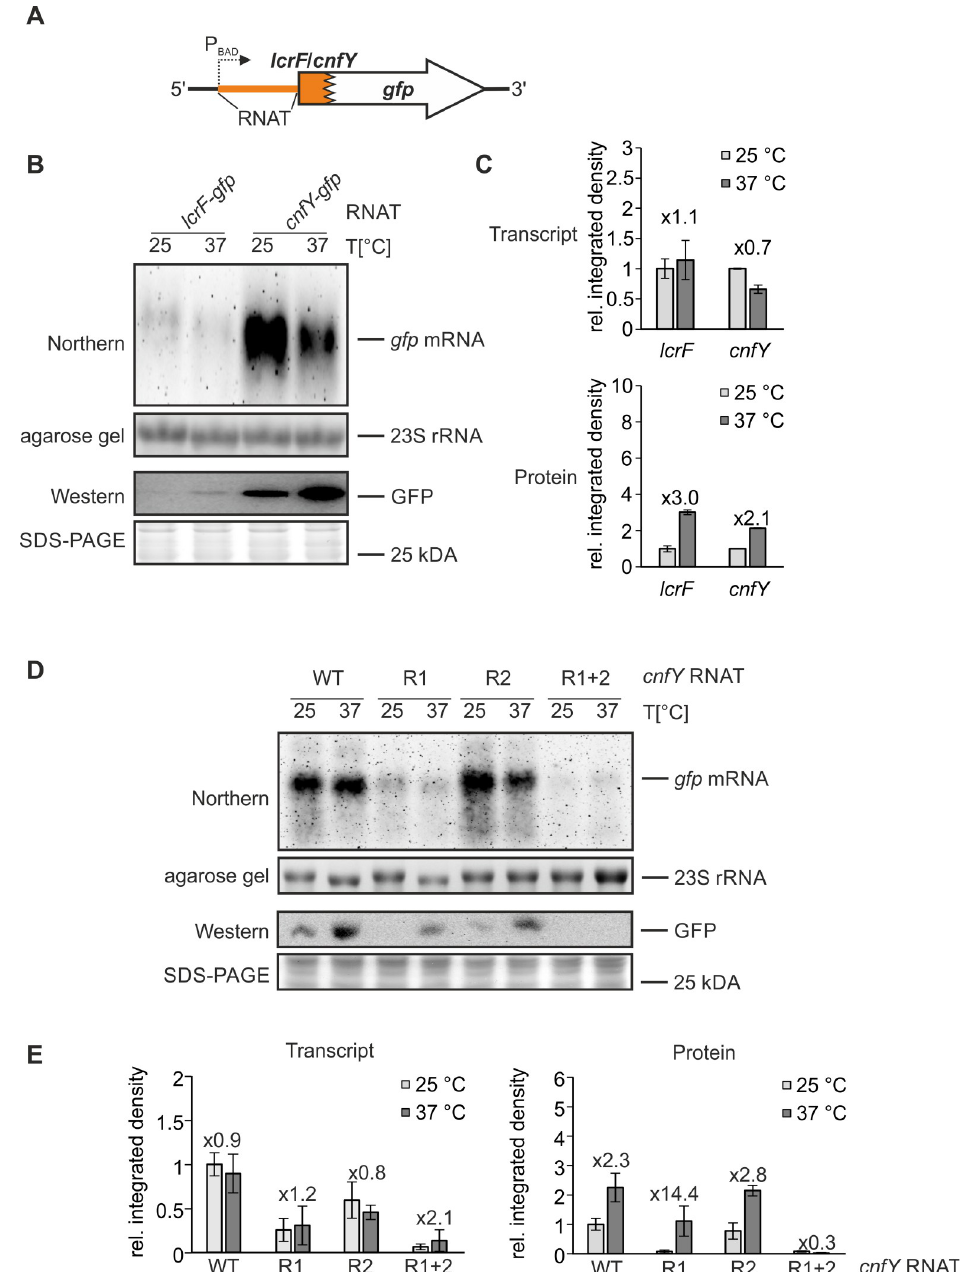
Fig 4. The cnfY RNAT facilitates translational thermoregulation of gfp expression. (A) Schematic representation of the translation cnfY : gfp reporter gene fusion on plasmid pBAD2- cnfY - gfp (pBO4481). (B) Cellular gfp transcript and GFP protein levels were measured by Northern and Western blot analyses, respectively. The lcrF RNAT translationally fused to gfp served as positive control (pBO4477). Y . pseudotuberculosis YPIII cells harboring the corresponding plasmids (technical triplicate per each construct) were grown to an OD 600 = 0.5 at 25˚C before transcription was induced with 0.1% (w/v) L-arabinose and the cultures were split. One half remained at 25˚C while the other was transferred into pre-warmed flasks (37˚C). After 30 min of incubation, samples were taken for Western and Northern blot analysis. (C) Densitometric quantification of signals from the Northern and Western blot experiments by the AlphaEaseFC software. The given values represent mean band intensities (37˚C/25˚C) and the corresponding standard deviations (three independent experiments). (D) The wild type (pBO4481) and the mutated cnfY RNATs (R1: pBO6505, R2: pBO6506, R1+2: pBO6507) were translationally fused to gfp and tested for differential GFP synthesis and gfp transcription in Y . pseudotuberculosis YPIII as described in Fig 3. Each experiment was performed at least